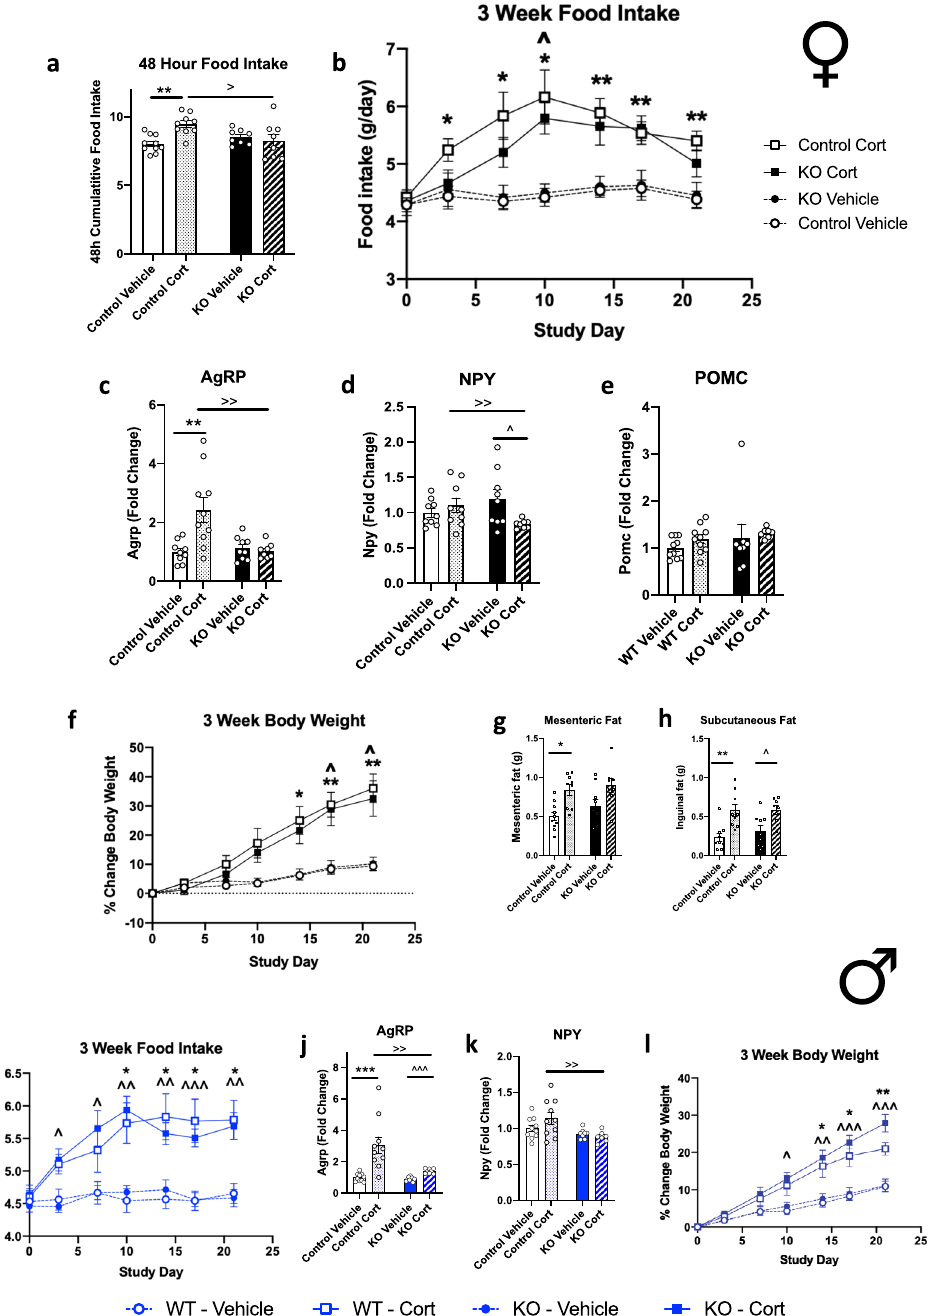
Figure 2. ( a – h ) Female AgRP-GR KO mice have delayed onset hyperphagia, but normal body weight gain with corticosterone (Cort) treatment. ( a ) 48 h, ( b ) 3 week food intake. ( c ) Agrp , ( d ) Npy and ( e ) Pomc mRNA expression in whole hypothalamus, ( f ) percent change in body weight, ( g ) mesenteric and ( h ) subcutaneous adipose tissue wet weight in female control and AgRP-GR KO mice treated with Cort in drinking water for 3 weeks. ( i – l ) Male mice. ( i ) food intake, ( j ) Agrp and ( k ) Npy mRNA expression in whole hypothalamus and ( l ) percent change in body weight in male control and AgRP-GR KO mice treated with Cort in drinking water for 3 weeks. ( a – h ) n = 7–10, ( i – l ) n = 7–10. ( a , b , f , g , h , i , l ) Two-way ANOVA with Tukey Multiple Comparison test, ( c , d , e , j , k ) Mann–Whitney non-parametric t-tests. * P < 0.01, ** P < 0.01, *** P < 0.001 control vehicle versus Cort, ^ P < 0.05, ^^ P < 0.01, ^^^ P < 0.001 KO vehicle versus Cort. > P > 0.05, >> P < 0.01 control Cort versus KO